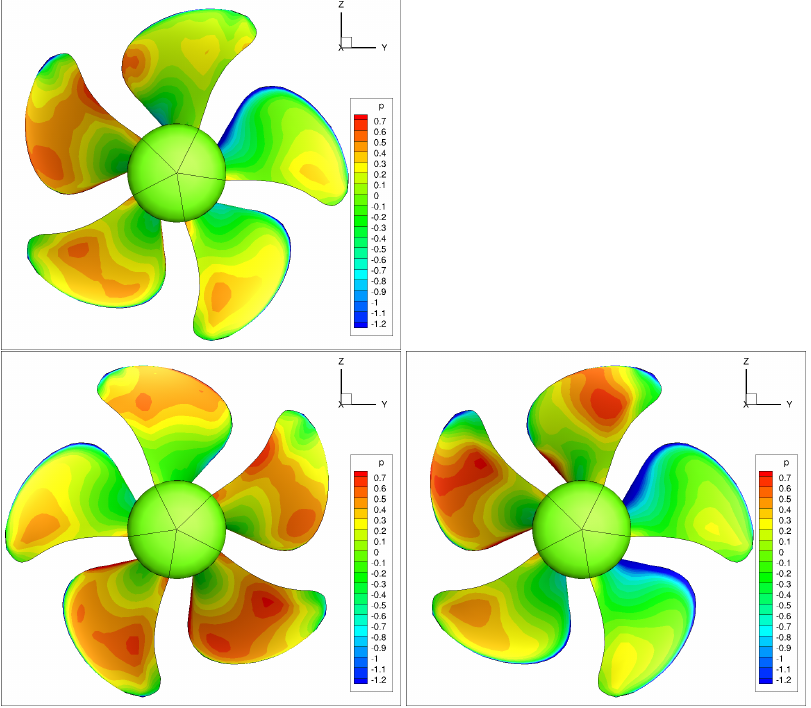
Figure 14. Propulsive performances of the model hull, J = 1.12: pressure distribution on face sides. ( Top ) 0 ◦ drift angle; ( Bottom ) 8.4 ◦ drift angle, portside propeller ( left ), starboard propeller ( right